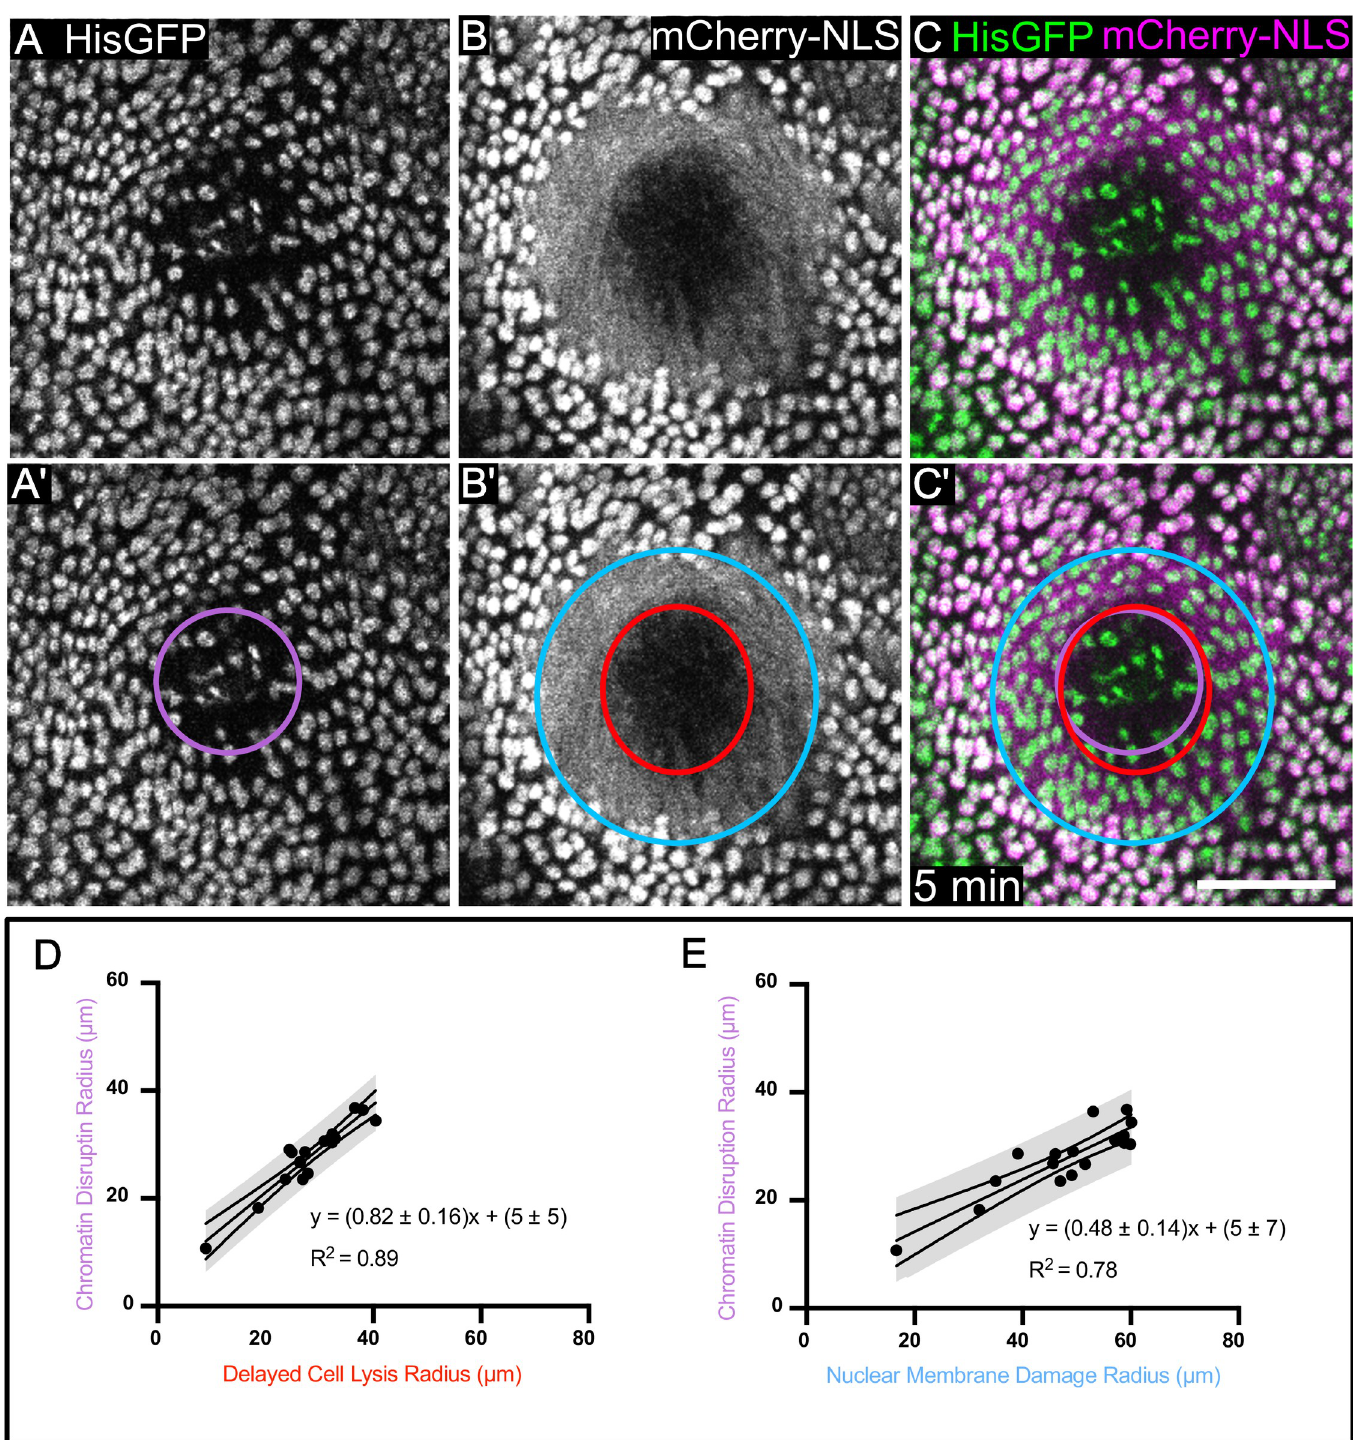
Fig 3. Histones reveal that within the region of nuclear membrane damage, some nuclei have intact chromatin whereas nuclei closer to the center have disrupted chromatin. (A) His2Av-GFP, which labels histones in chromatin, reveals a damage region with misshapen chromatin and decreased fluorescence, indicated with a purple circle in A’. (B) mCherry.NLS in the same wound reveals the region of nuclear membrane damage, (blue circle in B’) and the region of delayed cell lysis (red circle in B’). (C) The overlay of His2Av-GFP with mCherry.NLS shows that the region of chromatin disruption is much smaller than the region of nuclear membrane damage, but similar in size to the region of delayed cell lysis. (D-E) The relationships between the region of chromatin disruption and the regions of nuclear membrane damage (D) and of delayed cell lysis (E) are linear. The 95% confidence interval is indicated. n = 17 pupae. Scale bar = 50 μ m.